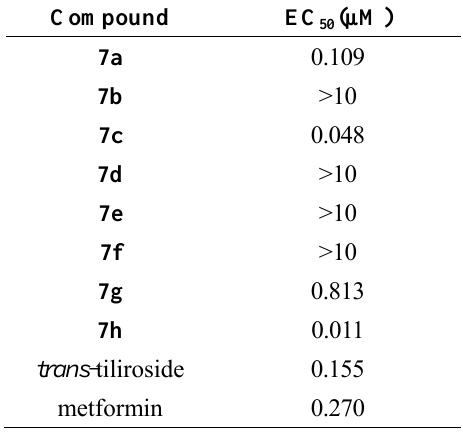
Table 1. Effects on glucose consumption of tiliroside derivatives in IR HepG2